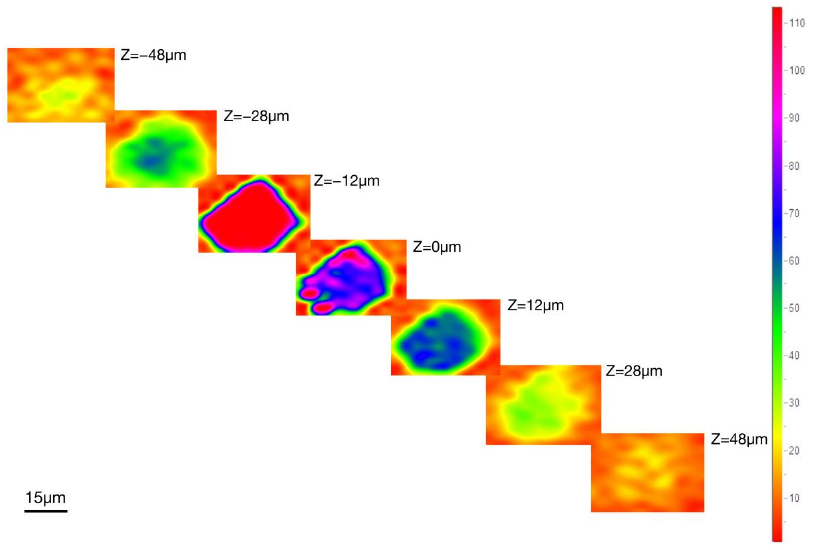
Figure 15. The 3D Raman mapping images show the variation in the strength of the 1310 cm − 1 peaks, outlining the hematite’s shape.